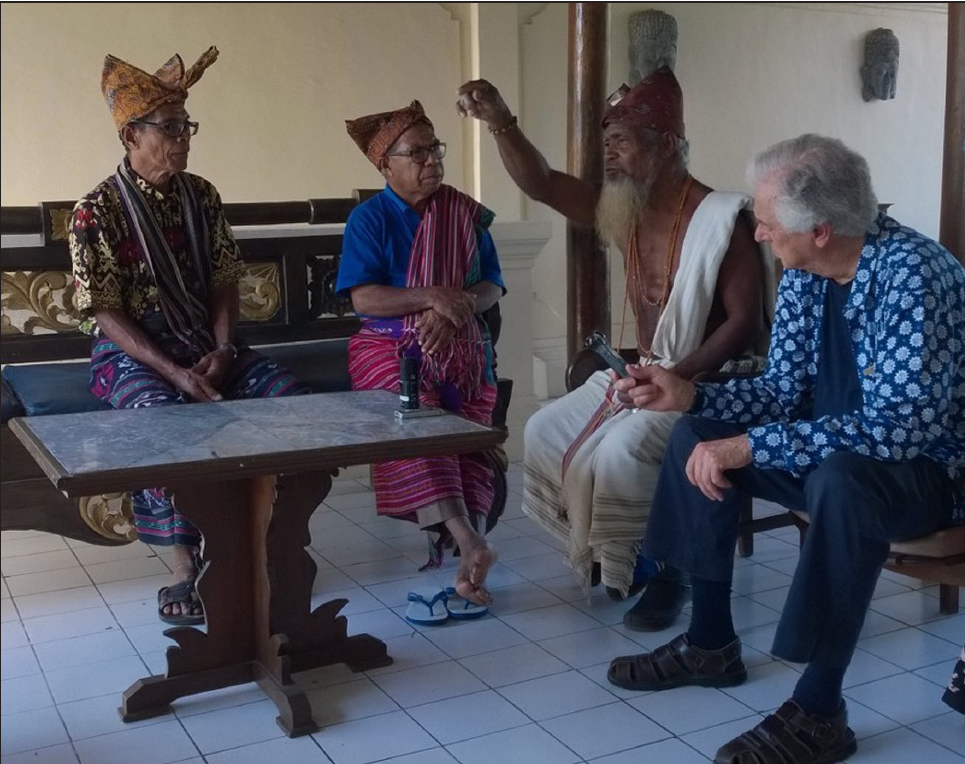
Figure 2: Piet Tahu performs the knowledge “Gardening in Wehali”. From left to right: Simon Bere, Gabriel Bria, Piet Tahu and James J. Fox. (Photo: Frog, Bali, 2019).